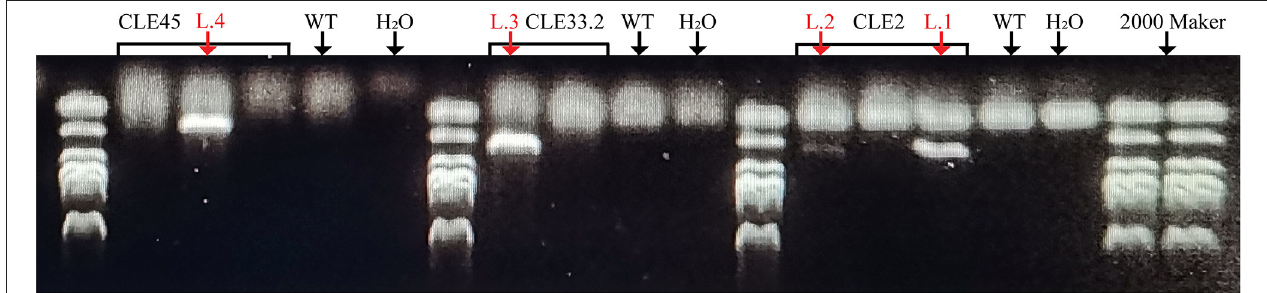
FIGURE 9 | The transgenic lines were verified by Agarose gel electrophoresis. The red arrows point to successful transgenic lines.